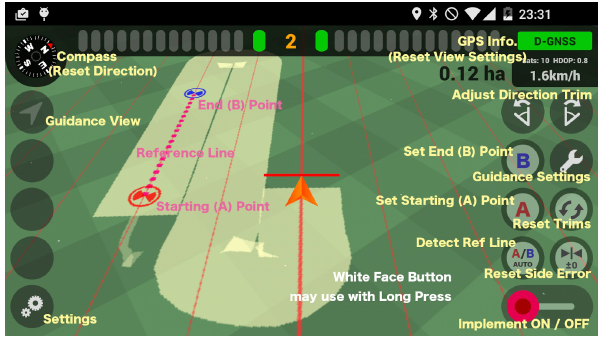
Figure 35. AgriBus-NAVI: Main interface.